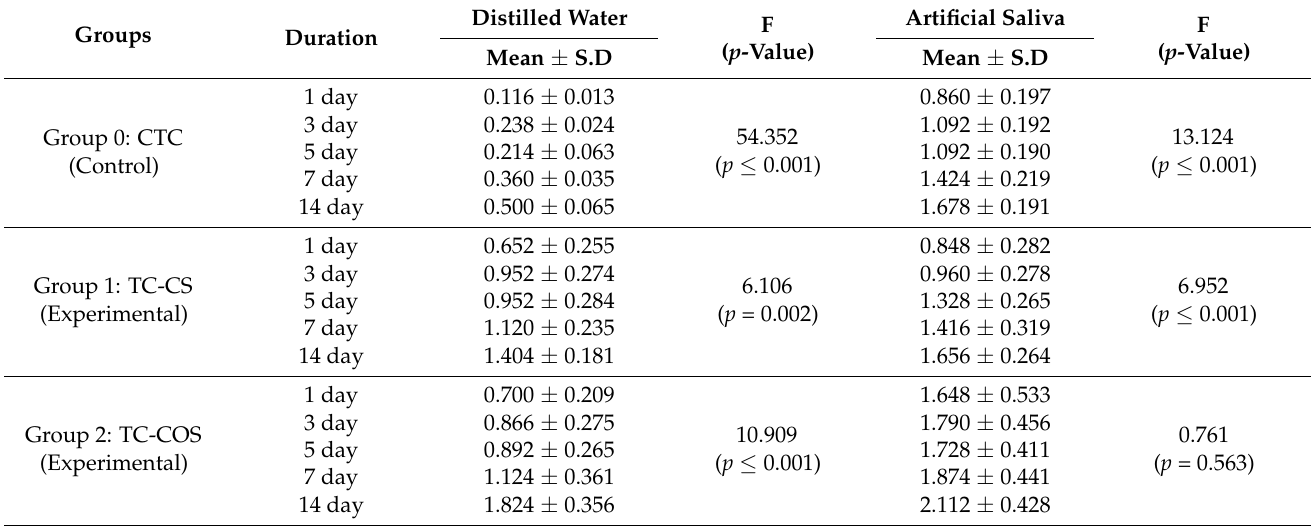
Table 2. Mean percentage solubility of specimens upon aging in different storage medium.